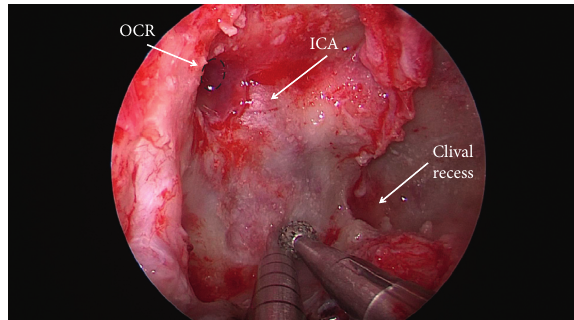
Figure 3: Intraoperative photo demonstrating drilling of the skull base through the endoscopic endonasal transpterygoid